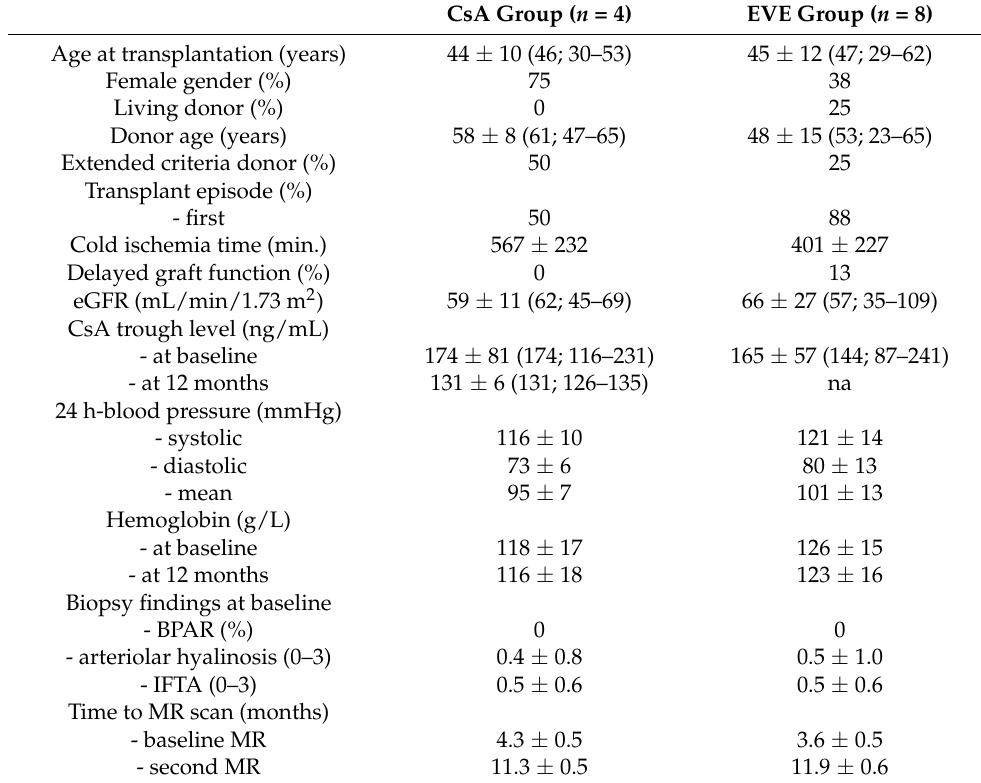
Table 1. Clinical characteristics of the subjects ( n = 12).